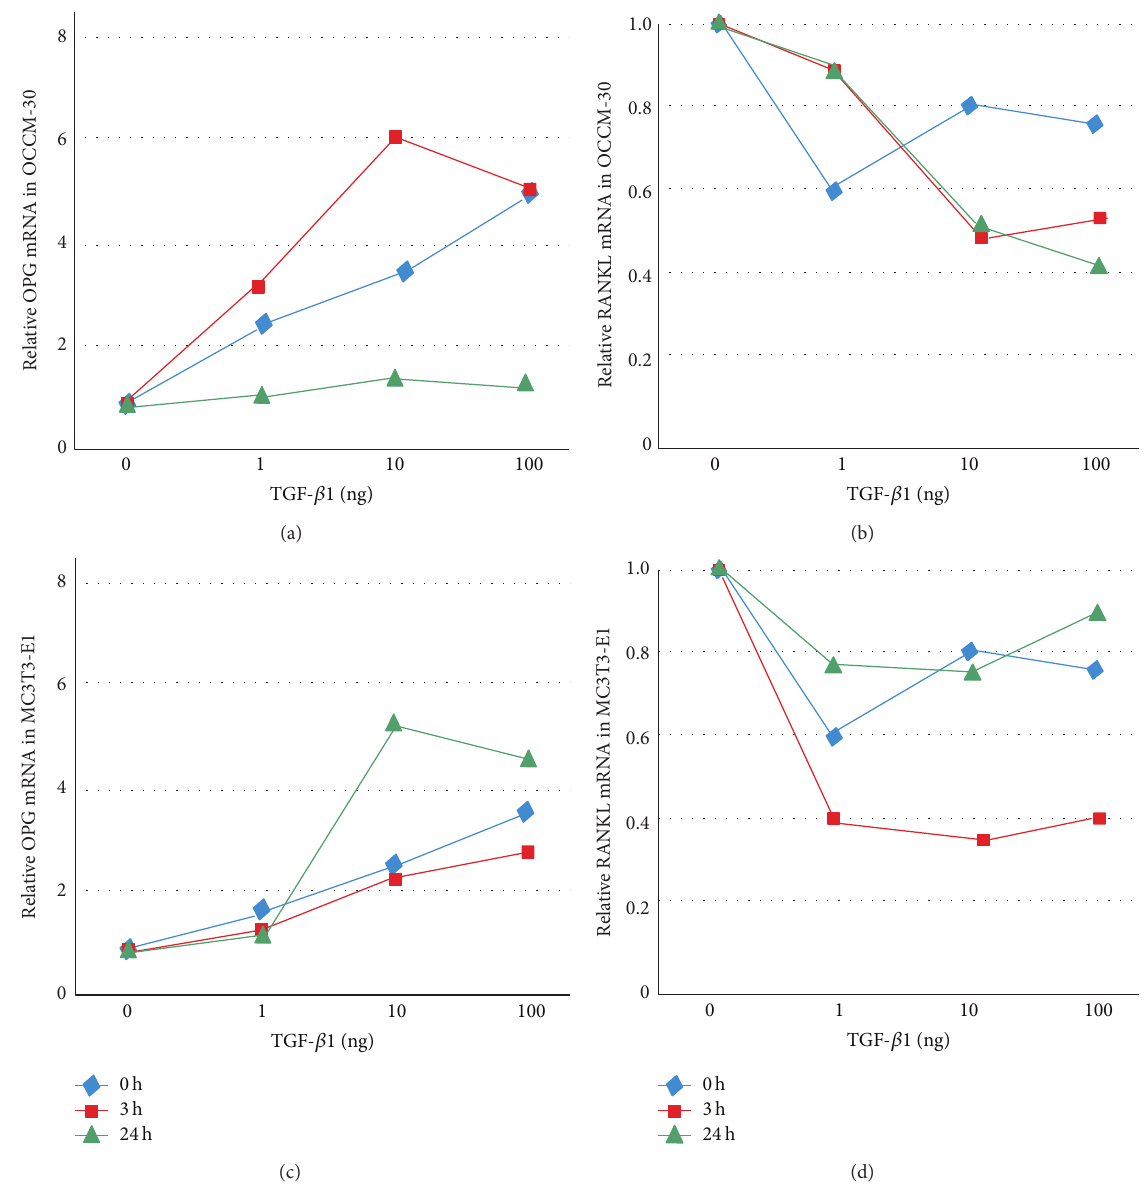
Figure 8: Change tendencies of OPG and RANKL under different mechanical compressive stress durations.